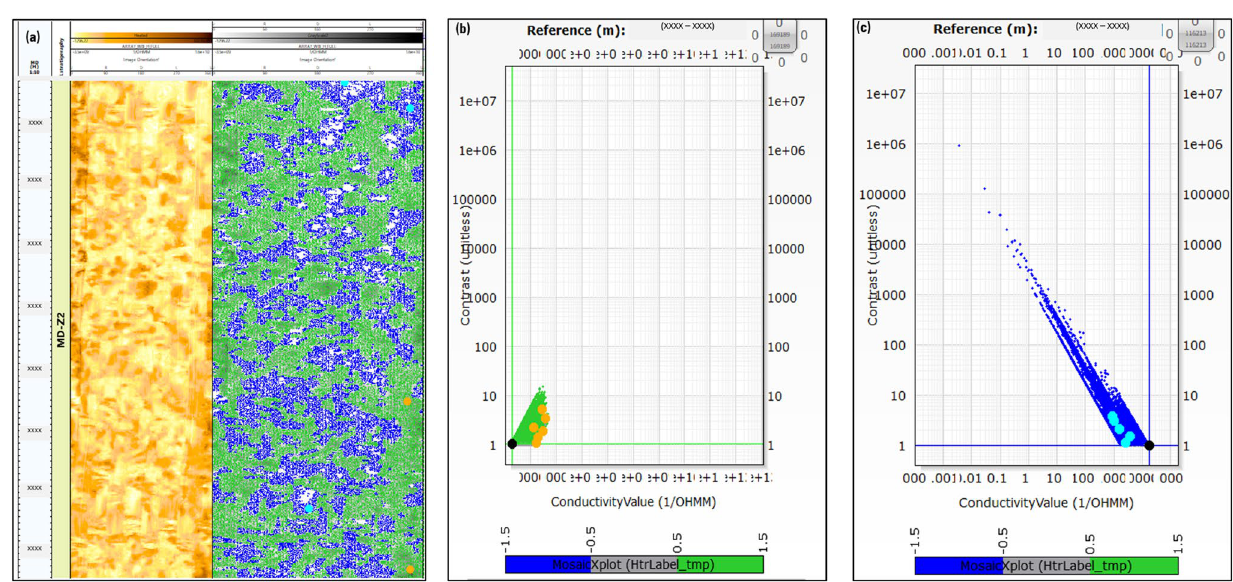
Fig. 15 a Mosaic index image, b Conductivity and c Resistivity of the matrix for well #4 after indexing resistive and conductive area